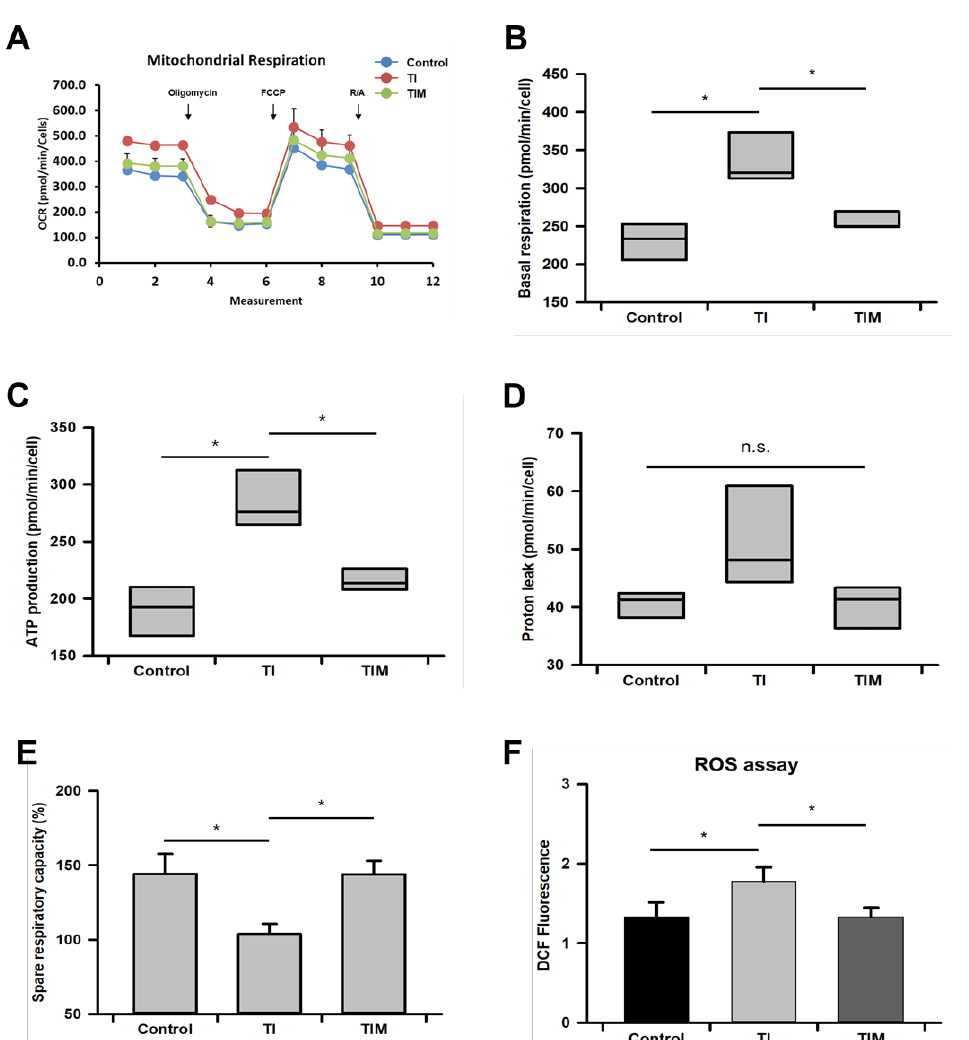
Figure 3. MIT-001 decreased mitochondrial metabolism of hPD-MSCs. ( A ) Comprehensive oxygen consumption rates in hPD-MSCs were measured using an extracellular flux analyzer. R/A: Rotenone/Antimycin. ( B – E ) Graphs of the basal respiration ( B ), ATP production ( C ), proton leak ( D ), and spare respiratory capacity ( E ). Cellular ROS levels were determined by measuring the fluorescence intensity of H2DCFDA after 488/555 excitation C: control, TI: TNF- α + IFN- γ , TIM: TNF- α + IFN- γ + MIT-001. Data are presented as the mean ± SEM ( n = 3). Statistical significance was determined by a one-way ANOVA. * p < 0.05.